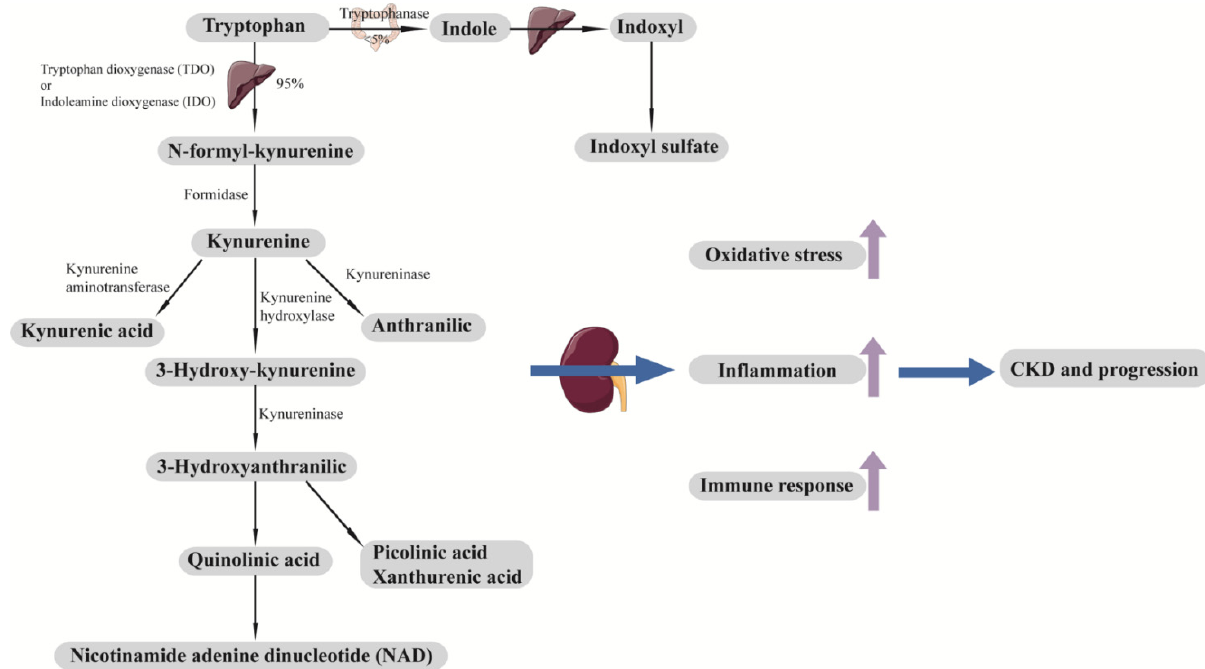
Figure 3. Tryptophan metabolic pathway and development and progression of CKD. Tryptophan is an essential amino acid that cannot be synthesized in the body. A minor fraction of tryptophan (<5%) is metabolized by the indole pathway to produce indoxyl sulfate. Most tryptophan (around 95%) is metabolized by the kynurenine pathway. Downstream metabolites of tryptophan, including indoxyl sulfate, kynurenic acid, picolinic acid, xanthurenic acid, quinolinic acid, and NAD, contribute to oxidative stress, inflammation, and immune response, which lead to the development and progression of CKD. CKD, chronic kidney disease; NAD, nicotinamide adenine dinucleotide. Tyrosine and phenylalanine have also been associated with kidney function and al- buminuria in patients with diabetes. A meta-analysis of five cohorts of patients with T2D